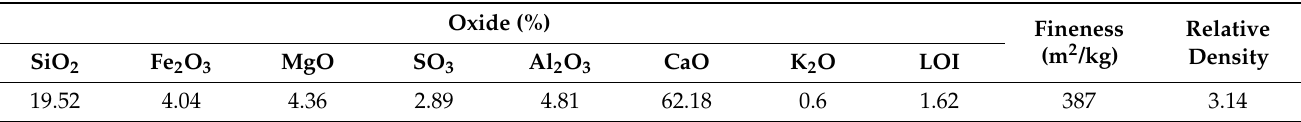
Table 1. Properties of Cement M500.